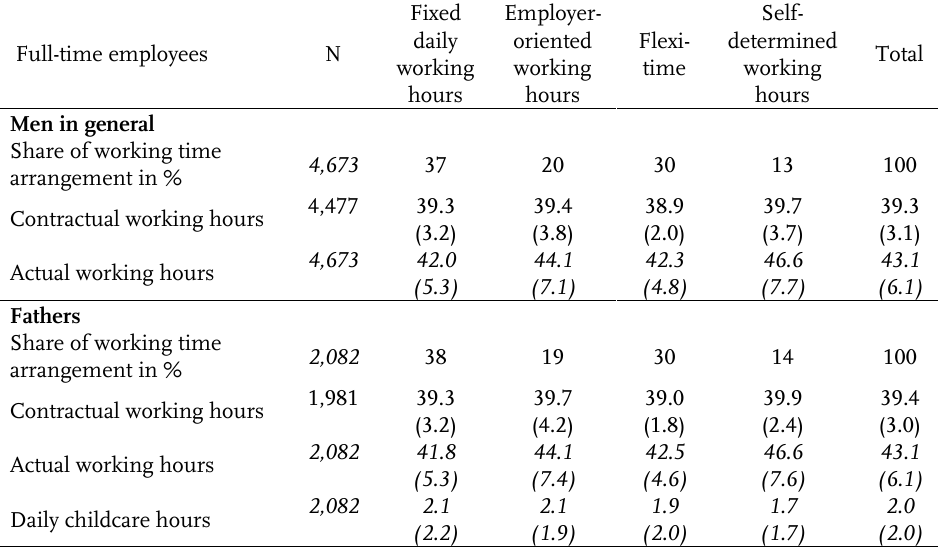
Table 1 : Type of working time arrangement of full-time employees,